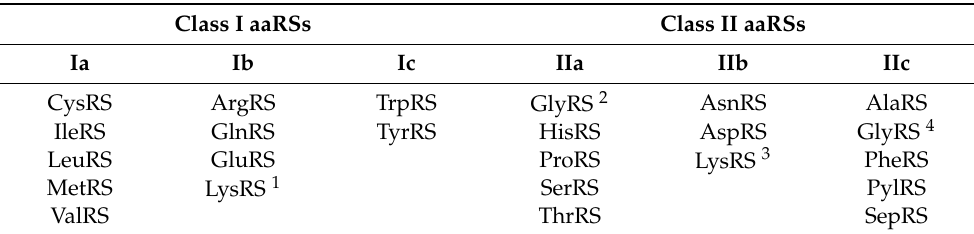
Table 1. Subgroups of class I and class II aminoacyl-tRNA synthetases